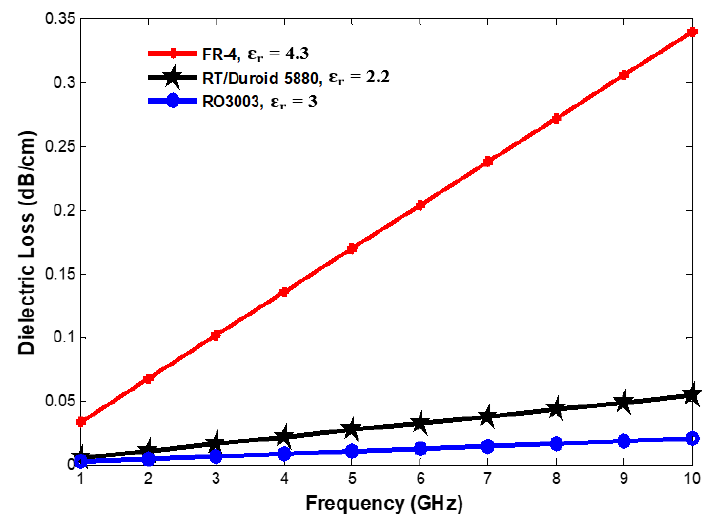
Figure 3. Dielectric loss versus frequency for different types of substrate materials at h/w = 0.04.